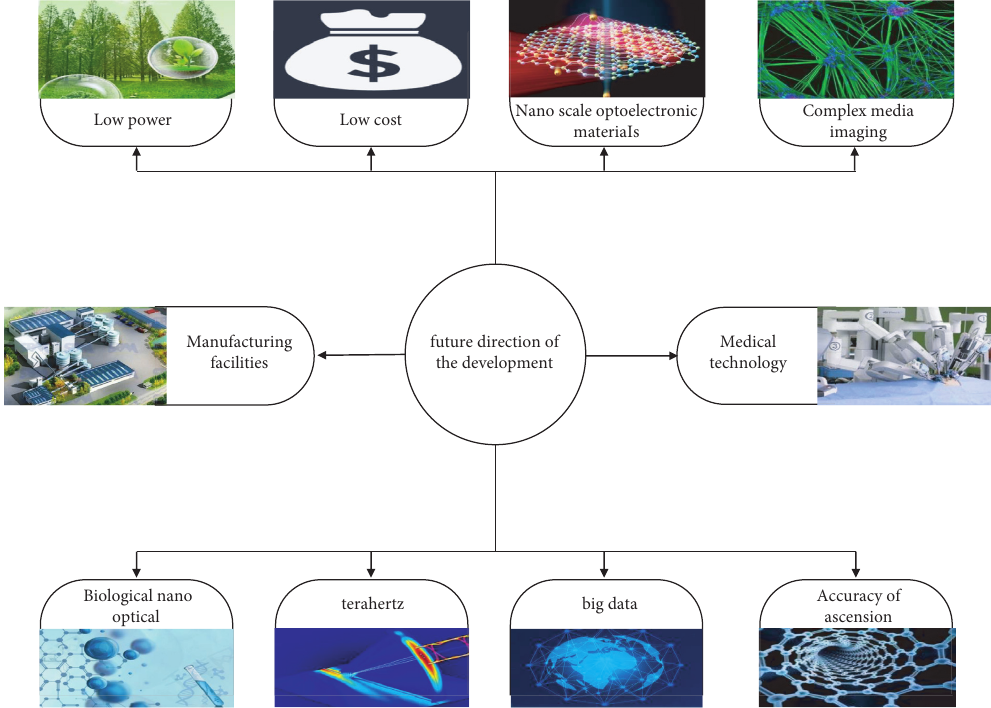
Figure 3: Future directions of nanooptics in medical imaging and photographic